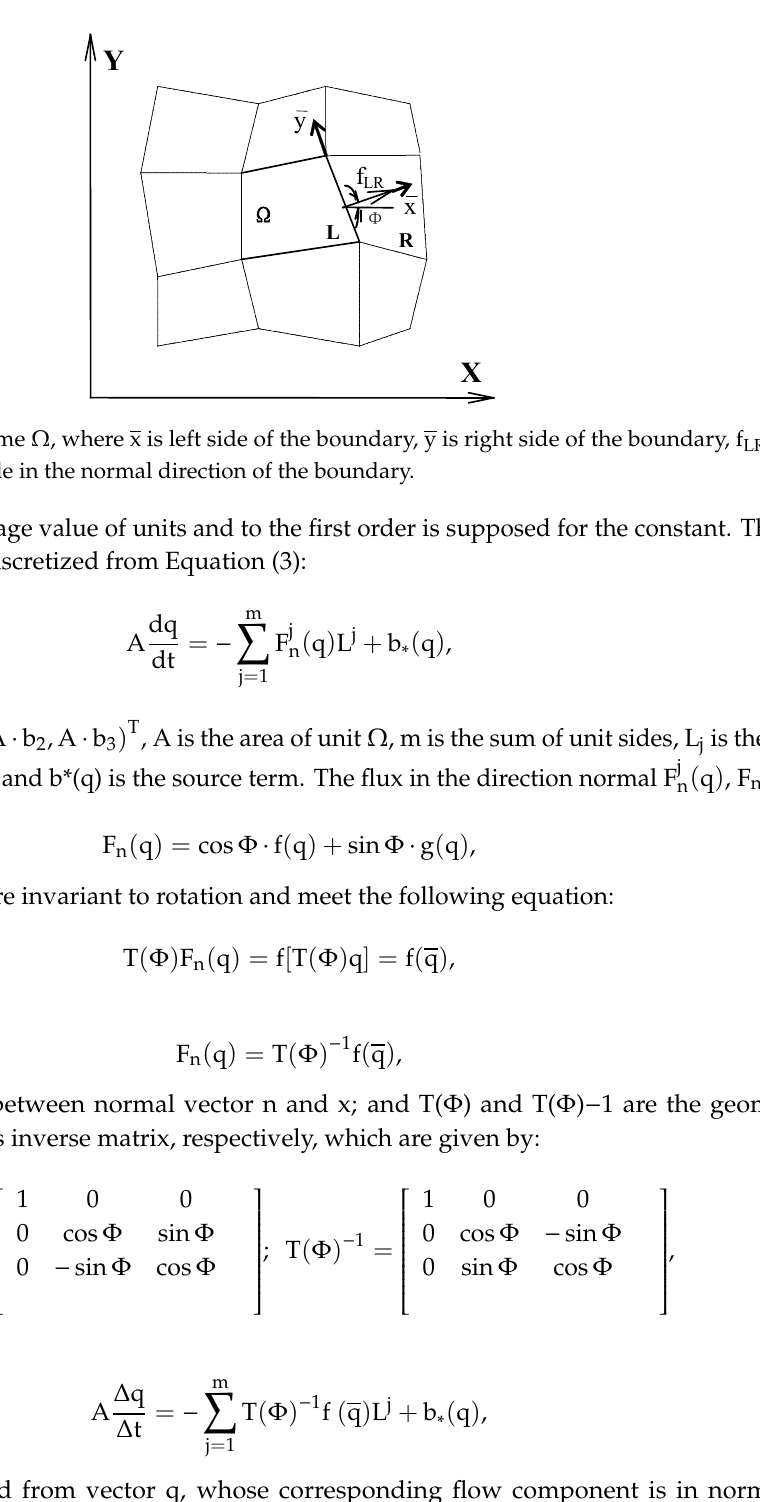
Figure 6. Calculated flood depth.